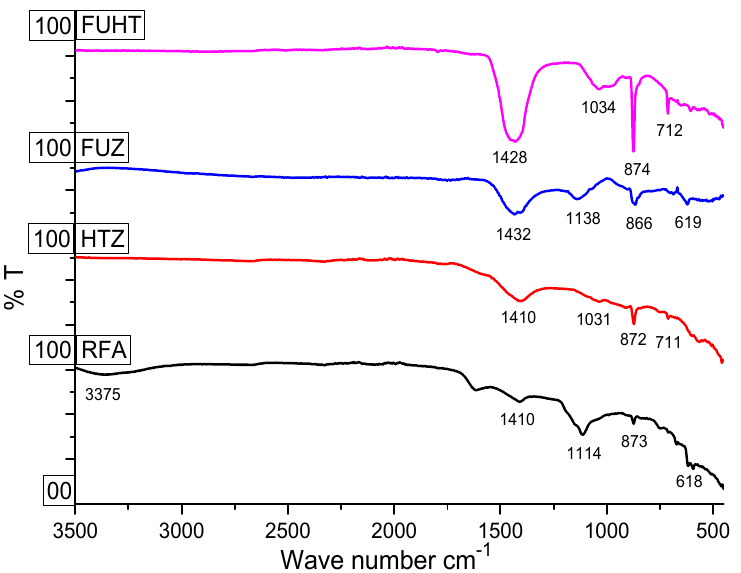
Figure 2. FTIR (ATR) spectra of RFA, hydrothermal synthesis of zeolite (HTZ), fusion synthesis of zeolite (FUZ), and fusion-assisted hydrothermal synthesis (FUHT), showing variation in functionality and surface chemistry.